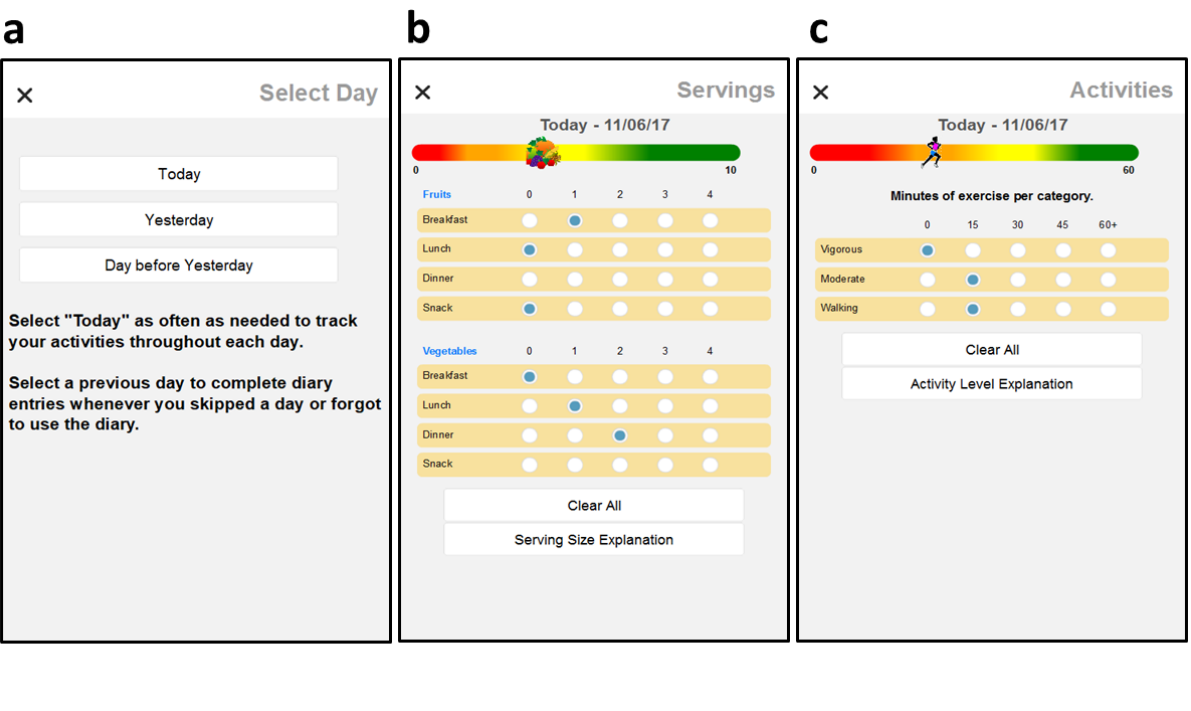
Figure 4. Users may catch up on missed diary entries for one or two days behind schedule (a). Labeling is changed to remind users that recall data are to be entered for specified day (b,